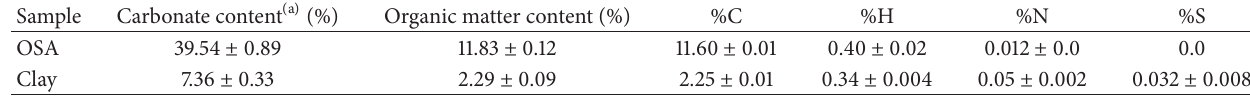
Table 1: Carbonate content, organic content, and CNHS analysis of raw materials.